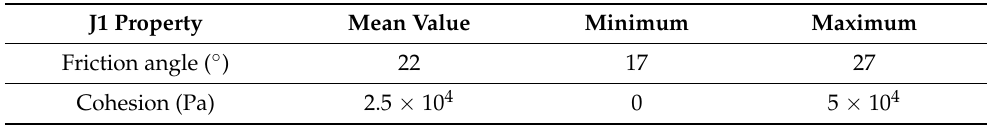
Table 4. Variations in dip, dip direction, persistence, friction angle of the folded bedding plane were characterized by mean, minimum and maximum